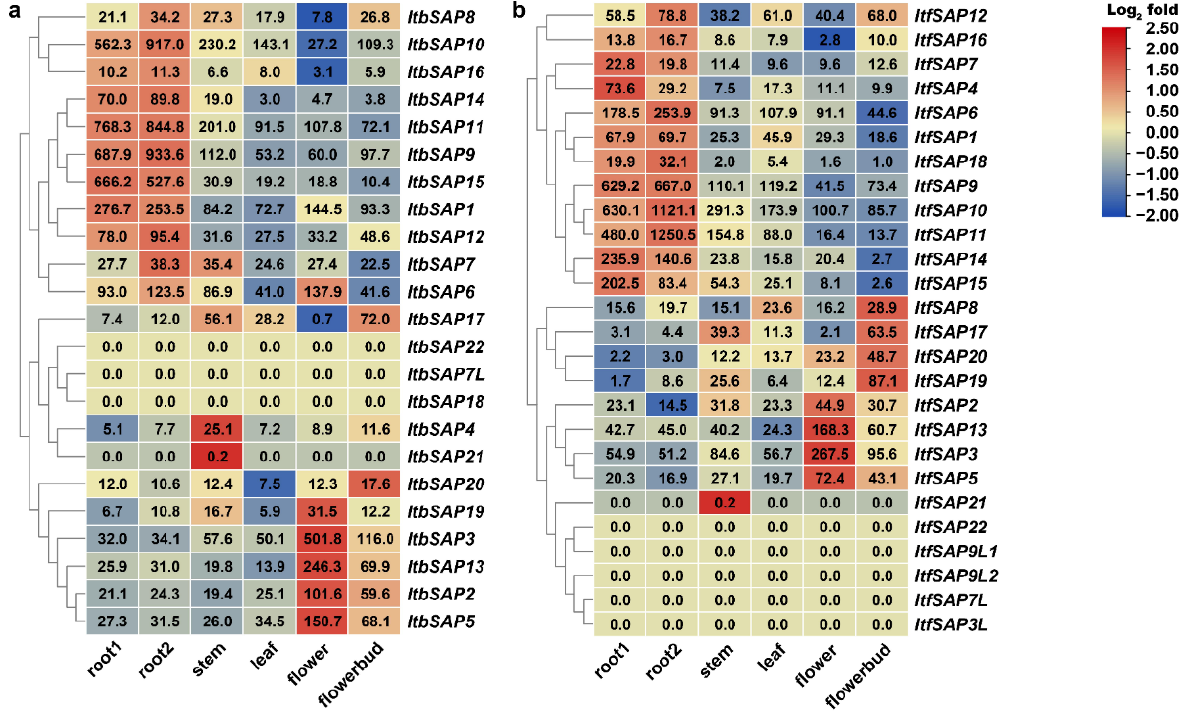
Figure 5. Gene expression patterns of ItbSAP s ( a ) and ItfSAP s ( b ) in different organs (root 1, root 2, stem, leaf, flower, and flower bud) as determined by RNA-seq. FPKM is shown in the boxes.